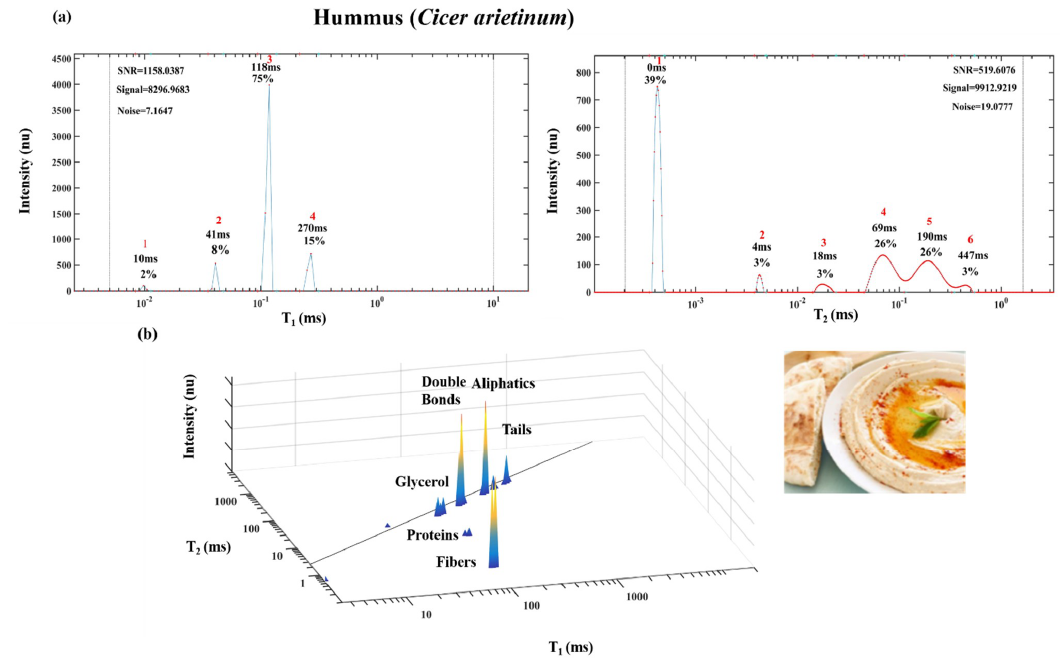
Figure 10. One-dimensional T 1 and T 2 spectra of dry Porphyridium cruentum sp. (red microalgae) ( a ) and 2D T 1 -T 2 spectra ( b ). Image of dry red microalgae (bottom right).